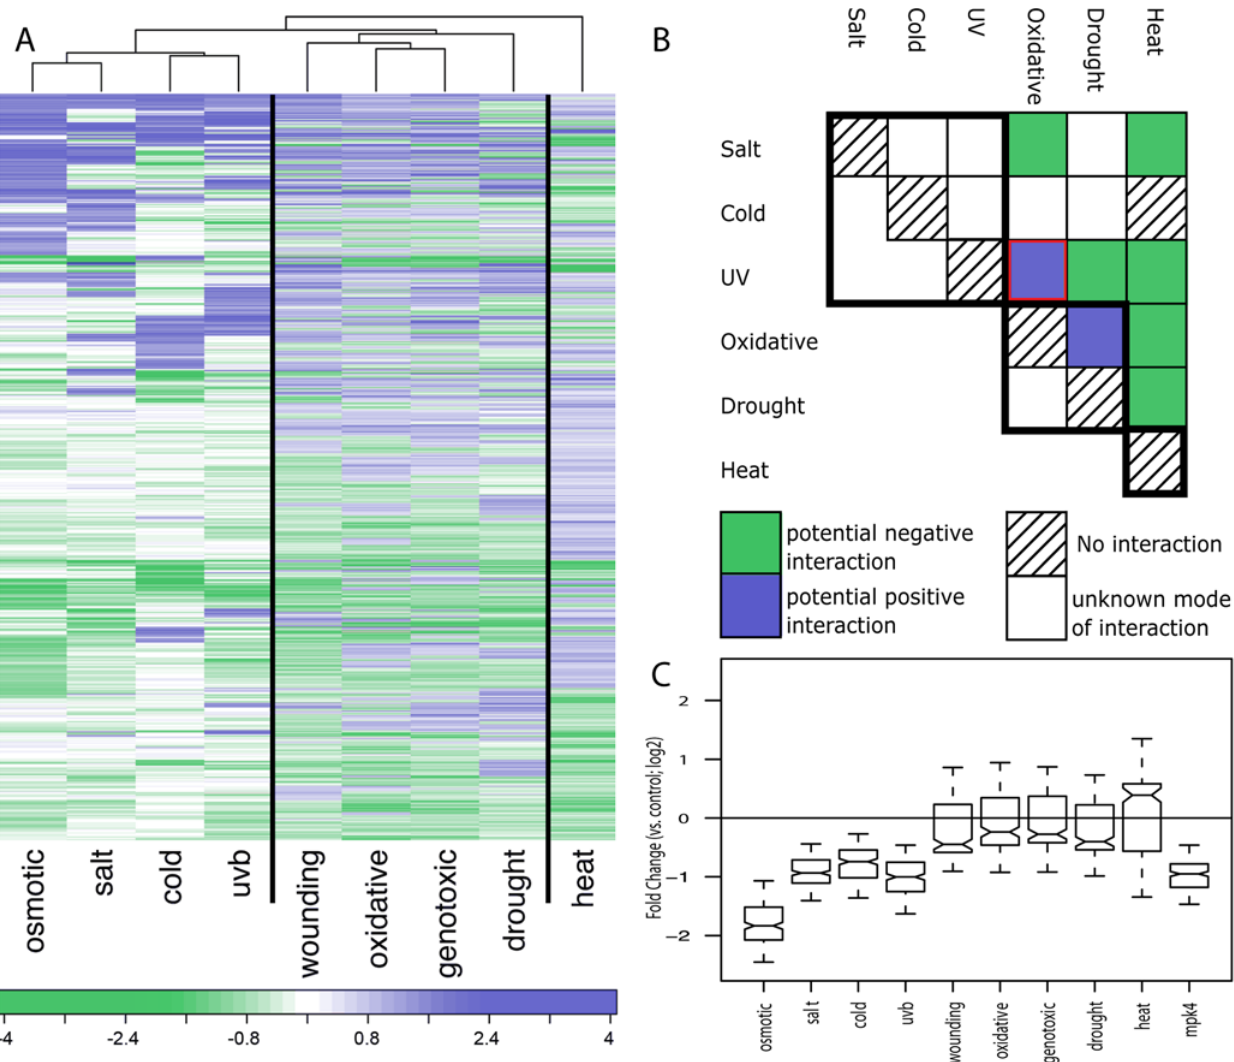
Figure 5. Tissue-specific abiotic stress. A) Expression profiles of the 657 tissue-specific stress response genes for nine different stress conditions. Color bar values correspond to log 2 -fold changes of gene expression values for stress versus controls. The clustering shown is based on congruence between the stress responses. Vertical lines indicate main groups borders. B) Agriculturally important stress combinations (adapted from [33]. Different combinations of abiotic stresses are presented in a matrix to demonstrate potential interactions with agronomic implications. Different interactions are color-coded to indicate potential negative (green, enhanced damage or lethality due to the stress combination) or potential positive (blue, cross-protection due to stress combination) effects. Black borders surround stress types with congruent response (main groups from 5A). Red border surrounds the only inconsistency between the grouping and known interaction (UV vs. Oxidative stress). C) Box plot of the expression profile of the 222 genes that are differentially expressed under all nine tissue-specific stress conditions and in the mpk4 mutant. Notches indicate 95% confidence interval for the median and whiskers two standard deviations.